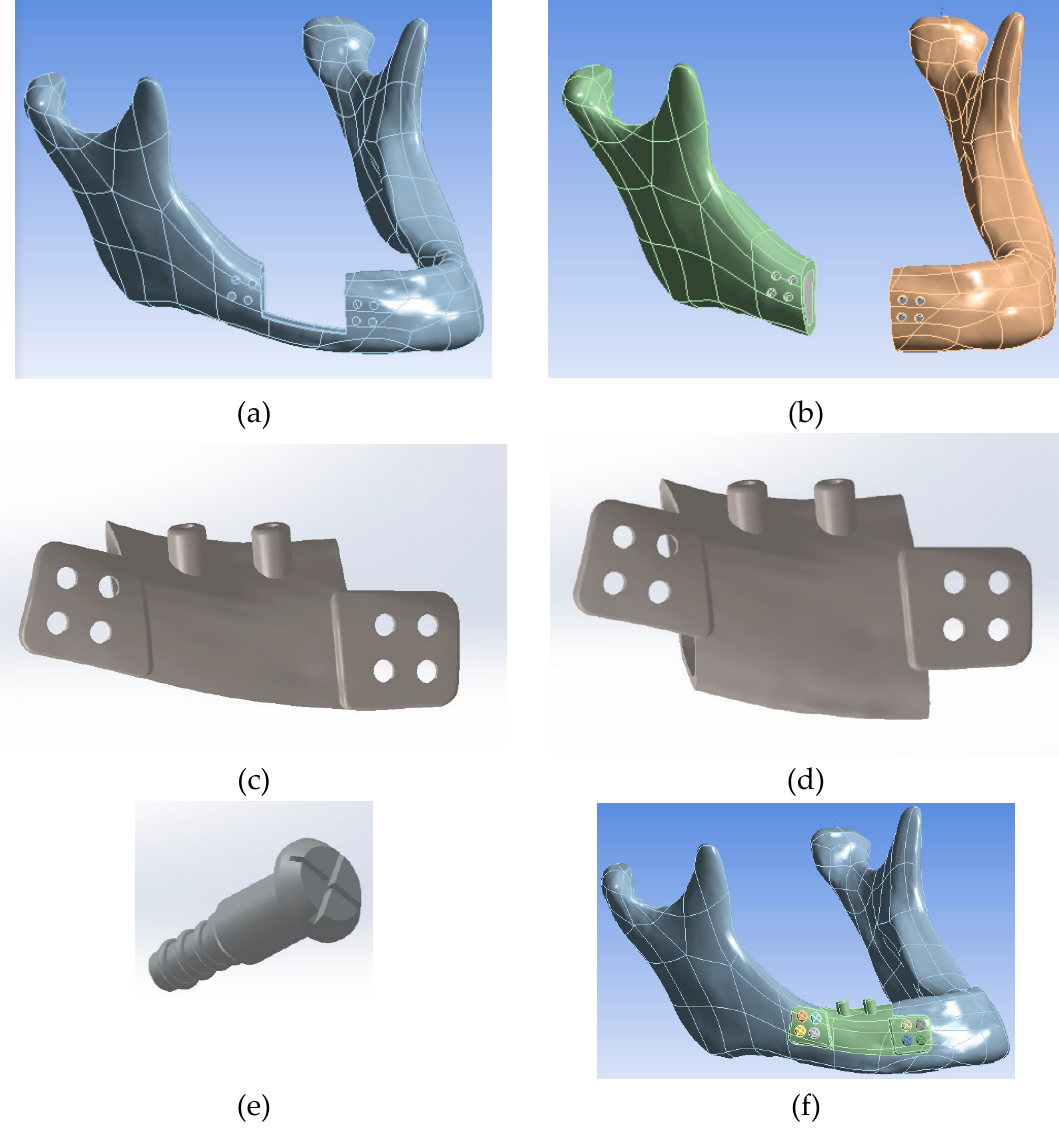
Figure 2. Resection conditions of the two mandibular defects modelled in this study—( a ) mild oral cancer and ( b ) severe oral cancer. Based on these conditions, two designs of 3D-printed Ti-alloy mandibular implants were conducted—( c ) Model 1 and ( d ) Model 2. Computer-aided design (CAD) models of ( e ) bone screws were used to ( f ) secure the 3D-printed Ti-alloy mandibular implant on the defective area of the mandible (Model 1 was shown as example).